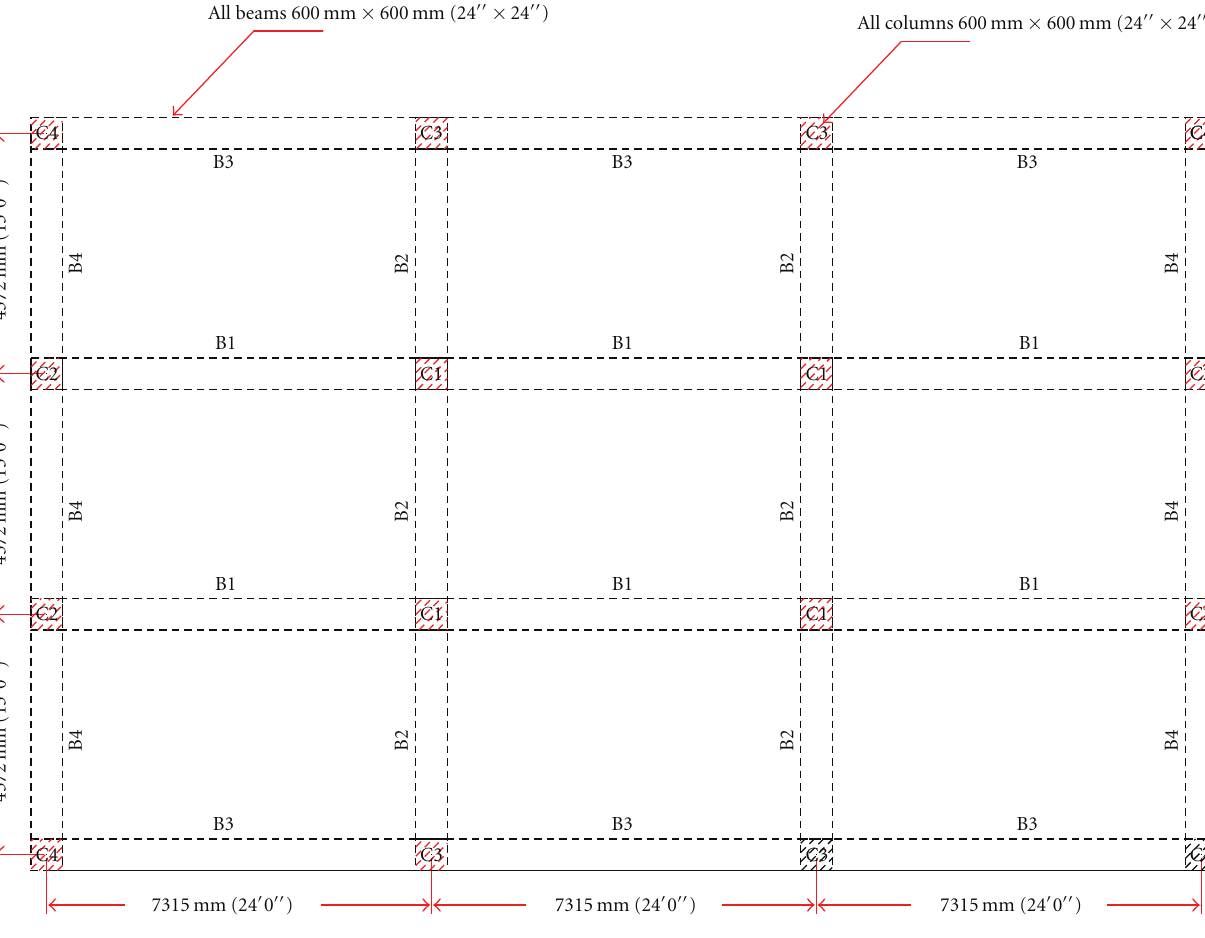
Figure 1: Plan of the prototype structure.